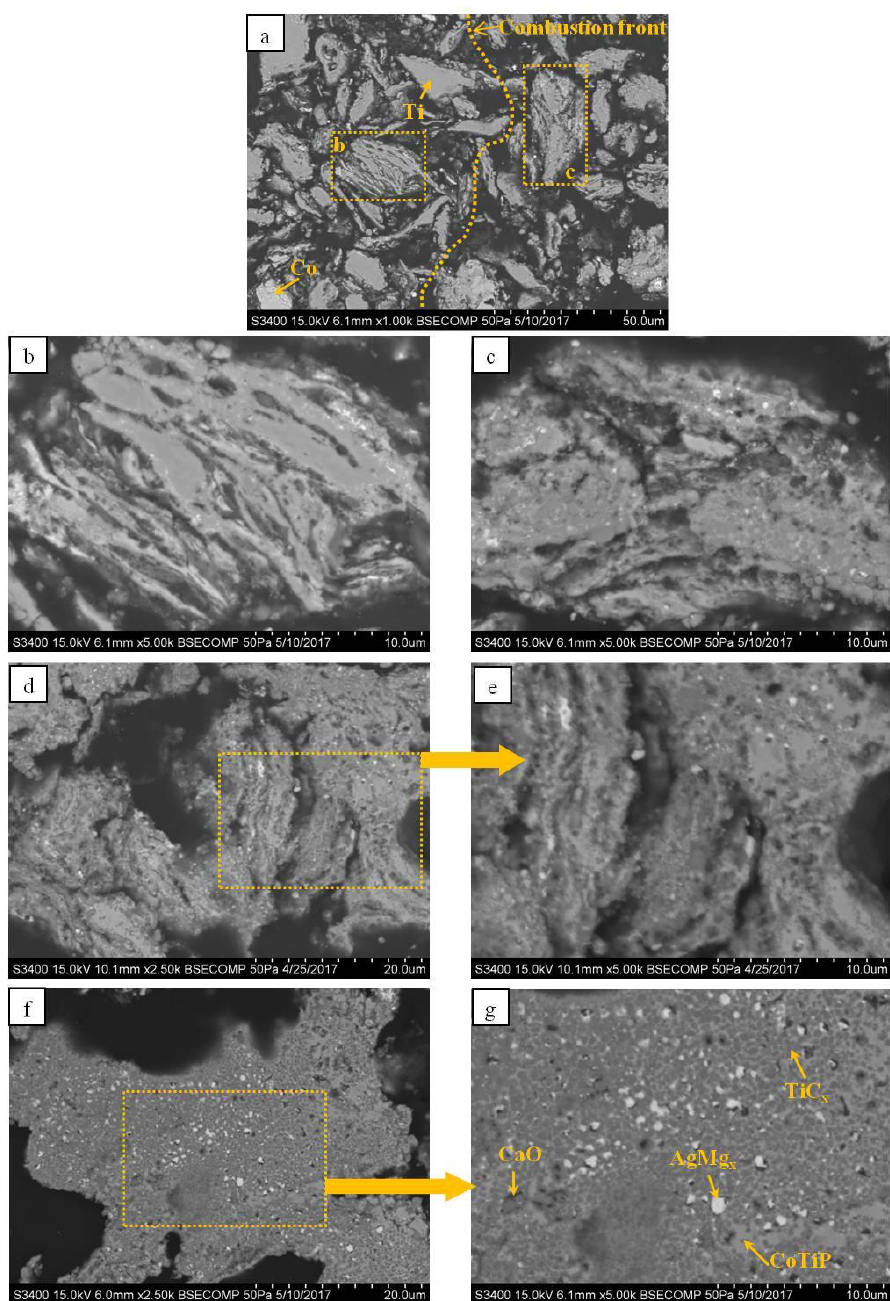
Figure 5. The microstructures of the stopped combustion front (SCF) from the Ti – C – Co – Ca 3 (PO 4 ) 2 – Ag – Mg mixture at X = 13% activated for 5 minutes in various areas of the quenched sample. ( a ) general view of the sample’s SCF; ( b ) initial charge mixture; ( c ) combustion zone; ( d , e ) post-combustion zone; ( f , g ) final product.